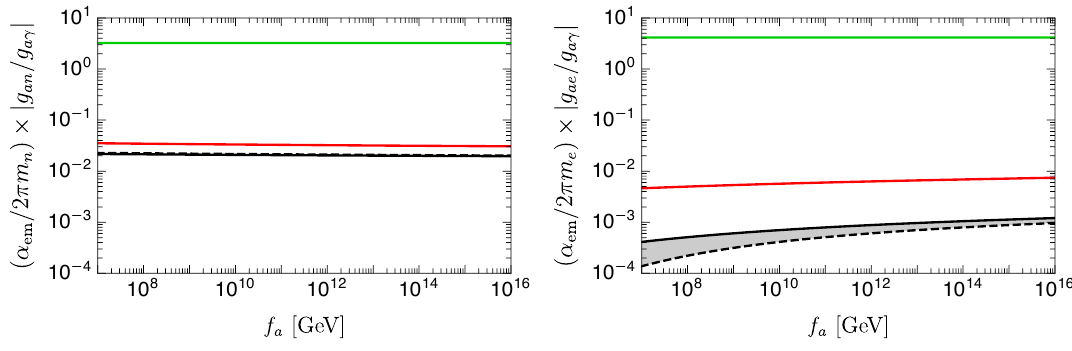
Figure 5 . The predicted ratios of the axion couplings from the minimal QCD axion models within the MSSM framework (green: DFSZ-like axions, black: KSVZ-like axions, red: string- theoretic axions). For KSVZ-like axions, the heavy exotic quark is assumed to have a mass between 10 − 3 f a (dashed black) and f a (solid black). For the MSSM parameters, we take tan β = 10 and m SUSY = 10